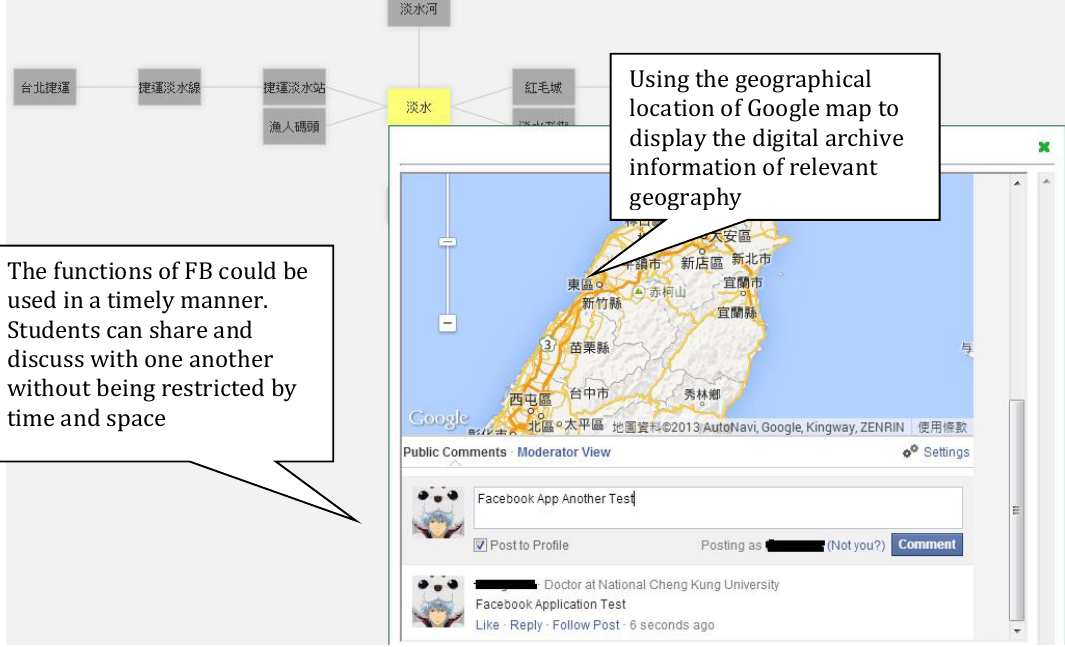
Figure 3. Community sharing mind map